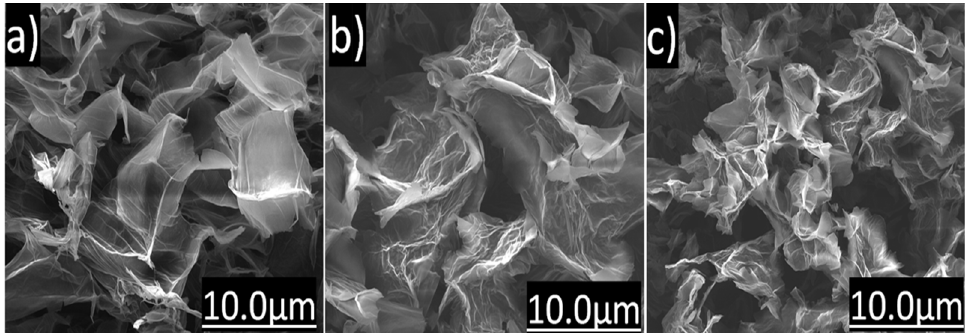
Figure 1. SEM image of ( a ) GO 3.0 g, ( b ) GO 4.5 g and ( c ) GO 6.0 g samples.